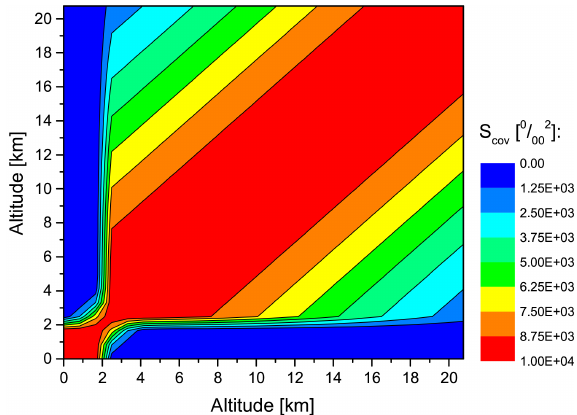
Figure 6. Covariances used for estimating the quality of the simu- lated averaging